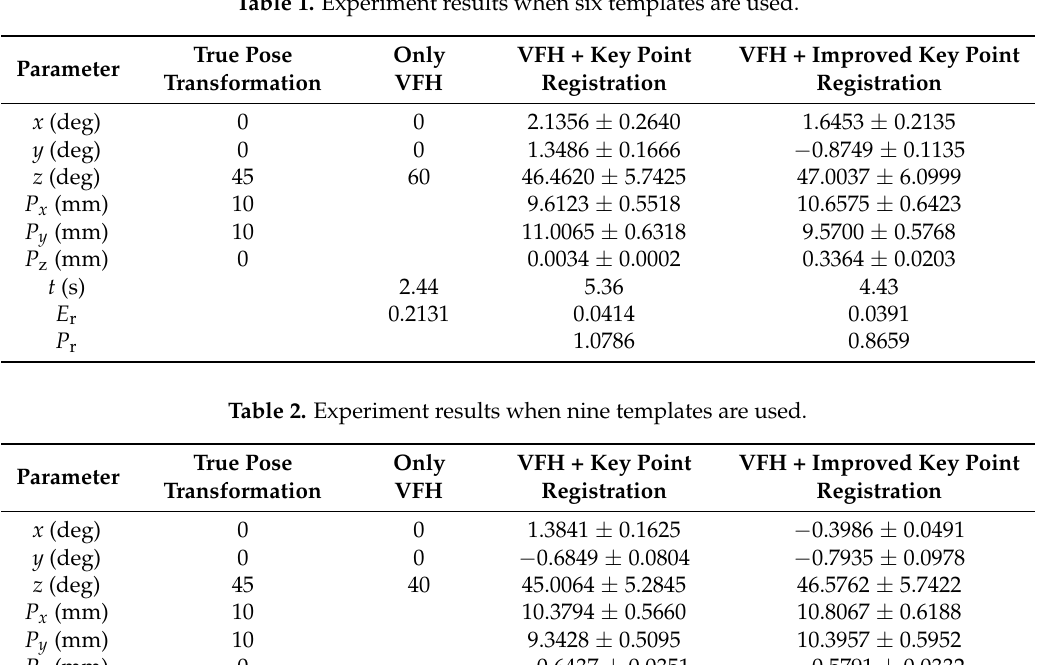
Table 1. Experiment results when six templates are used.